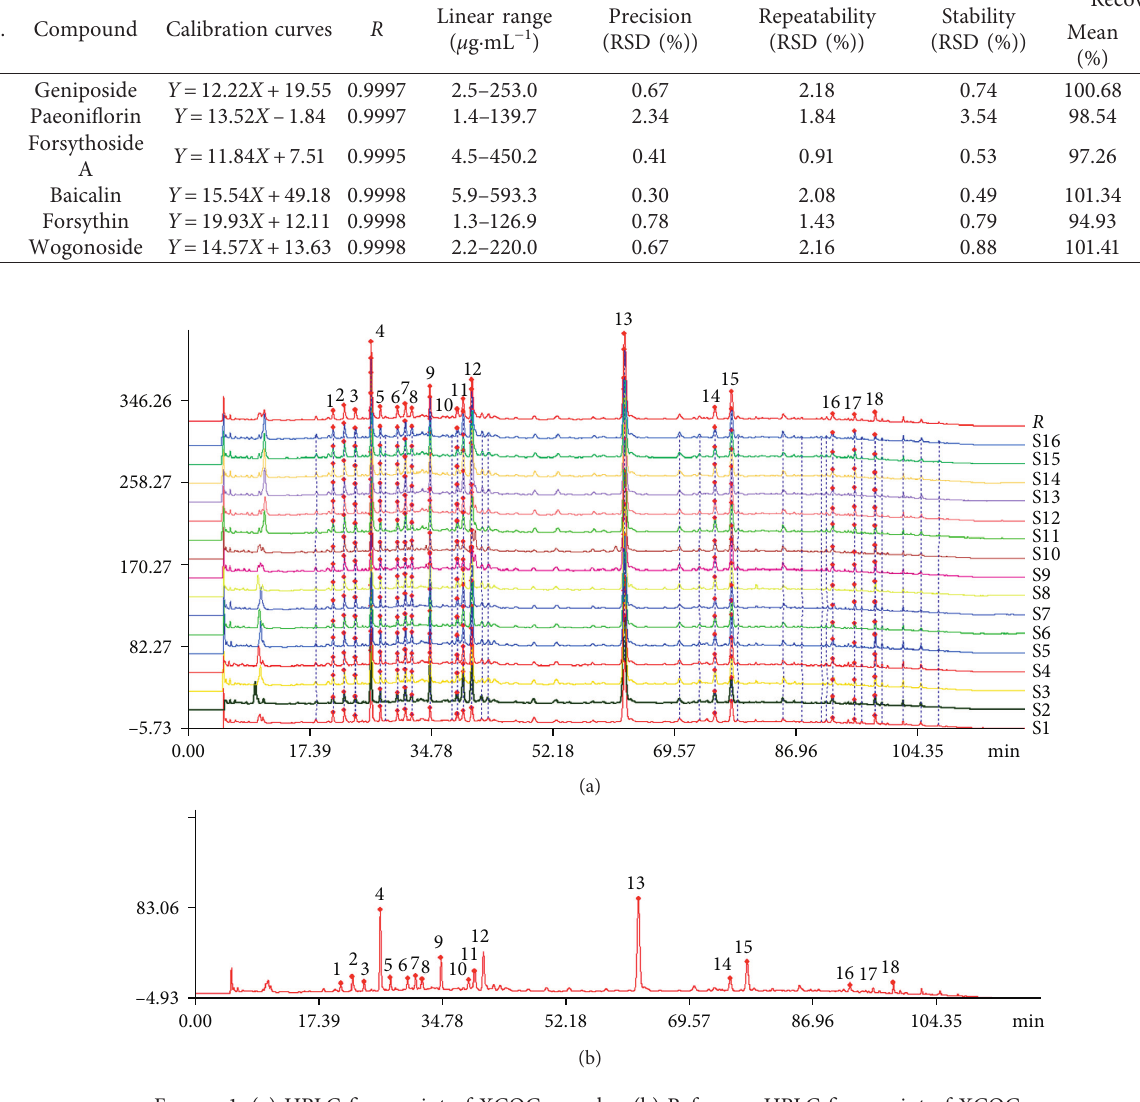
Figure 1: (a) HPLC fingerprint of XCQG samples. (b) Reference HPLC fingerprint of